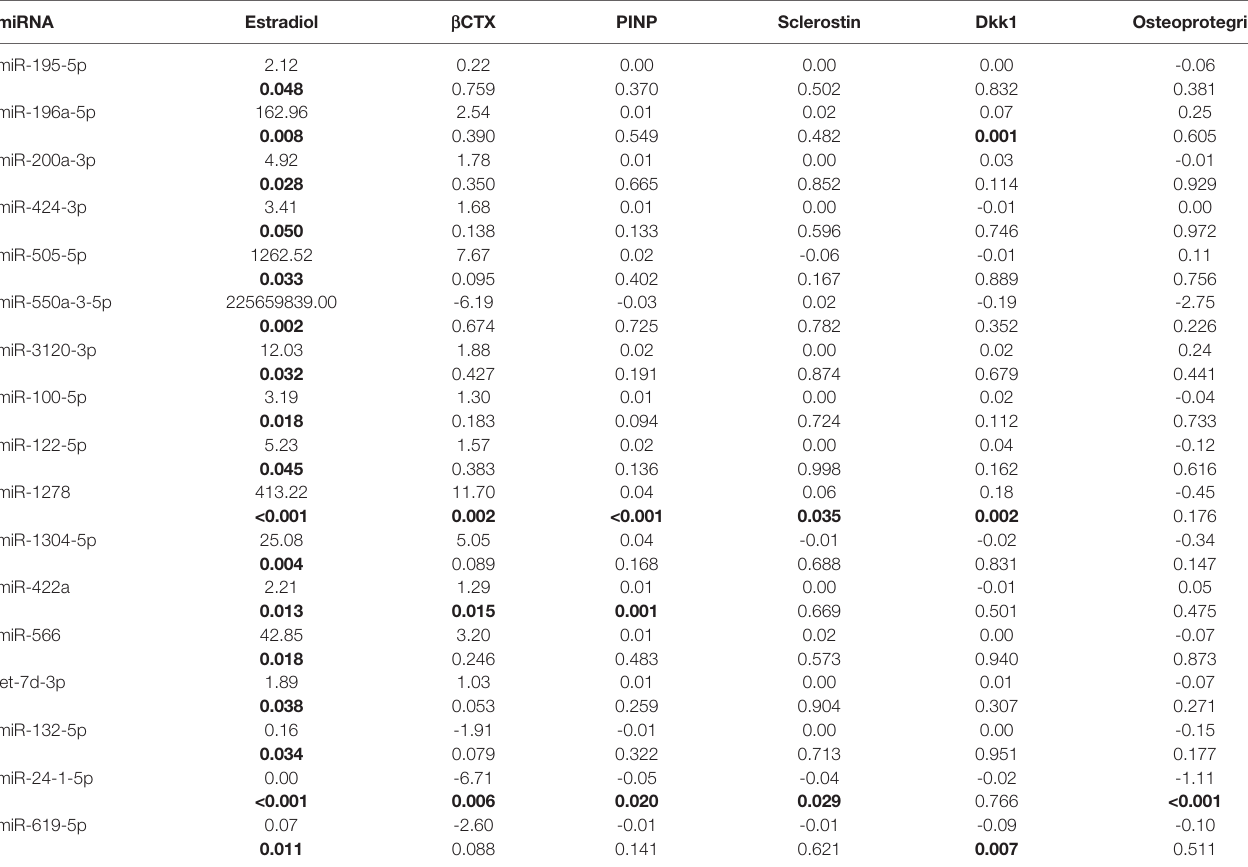
TABLE 2 | Association of changes in 17 miRNAs with disparate concentrations between suf fi cient and low estrogen levels in serum with biomarkers in 11 untreated women before oophorectomy and 201 days after, and in 11 women initially untreated for 508 days and then treated with estradiol for 203 days. miRNA Estradiol b CTX PINP Sclerostin Dkk1 Osteoprotegrin